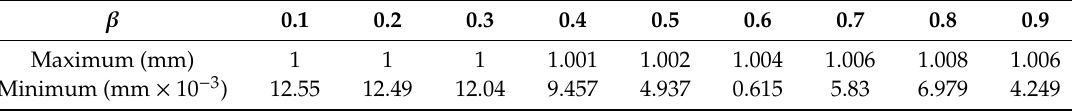
Table 3. Maximum-minimum deformation of variable-angle laminates of [0 ± < 20 ( β ) 60 >] 2s .